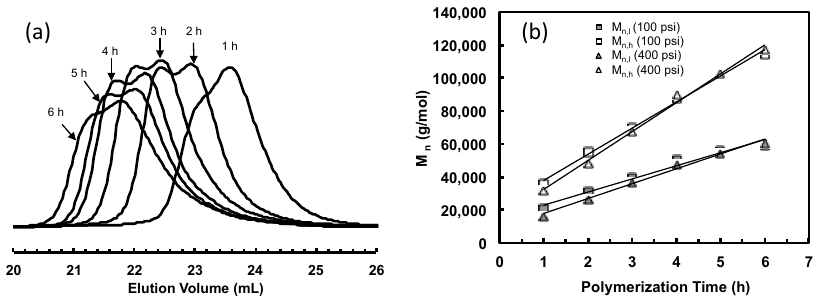
Figure 10. ( a ) GPC elution curves for polyethylene samples taken at different polymerization time in ethylene polymerization using 3a at 5 °C and 100 psi in chlorobenzene; and ( b ) M n,l and M n,h values of the deconvoluted peaks as a function of polymerization time for polymers produced at 100 psi and 400 psi using 3a .